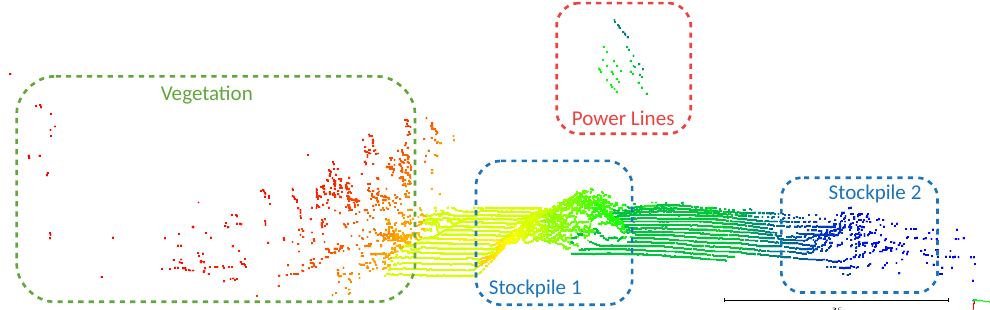
Figure 13. Object identification in the point